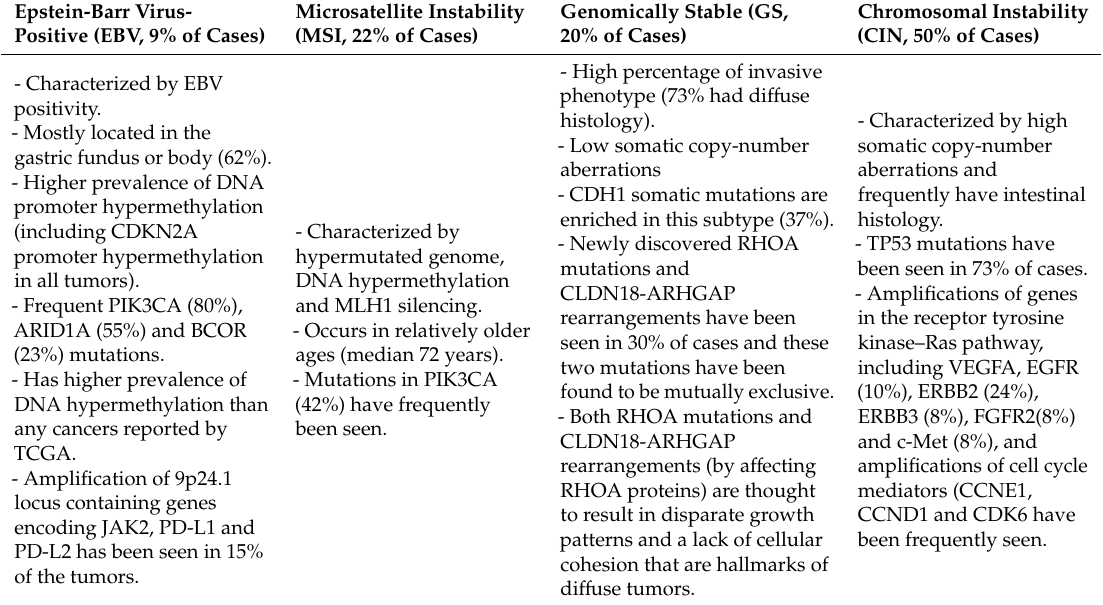
Table 1. The Cancer Genome Atlas (TCGA) Classification.